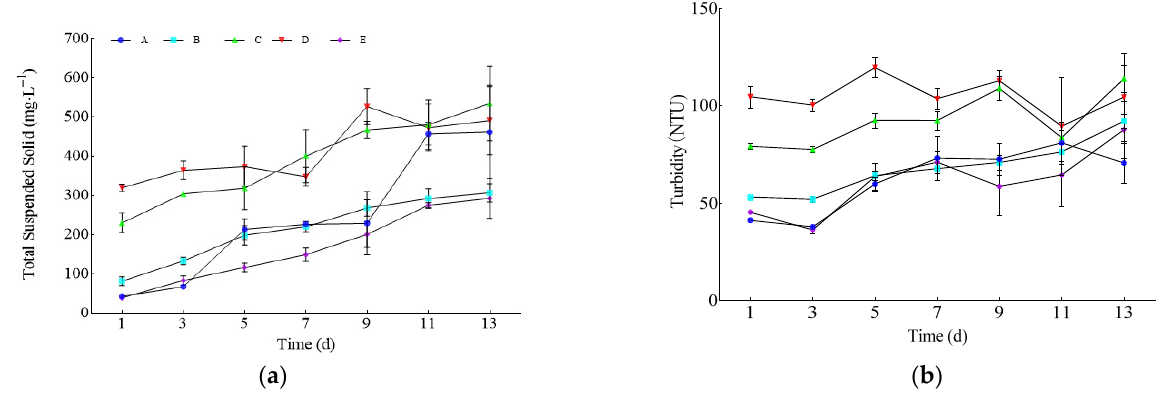
Figure 1. The variation in ( a ) total suspended solids (TSS) levels and ( b ) turbidity of five treatments.